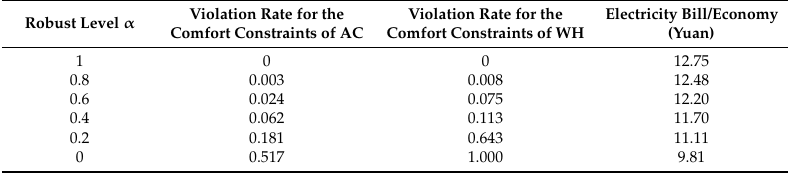
Table 4. The economy and violation rate of schedules with different robust